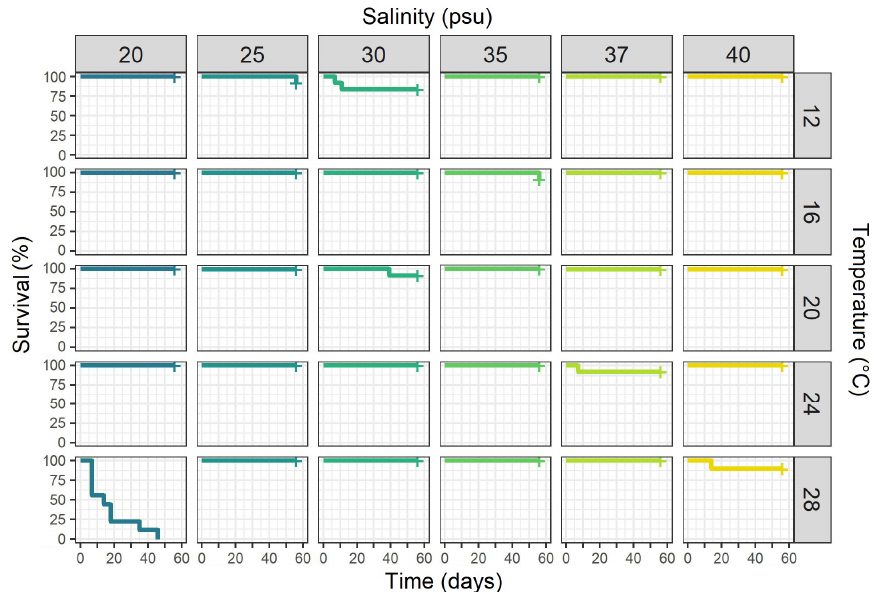
Figure 2. Kaplan–Meier survival curves for Aurelia solida polyps kept at 30 different combinations of temperatures and salinities over 56 days of the experiment ( n = 12 per combination). Table 1. Statistical analysis for several variables measured on Aurelia solida kept under different temperatures and salinities. Results for polyp survival, polyp asexual reproduction, and ephyra survival are presented as the output of chi-squared tests ( 𝚾 ²); those for ephyra growth as Anova output (F-statistic). Significant results ( p < 0.05) are highlighted in bold. Variable